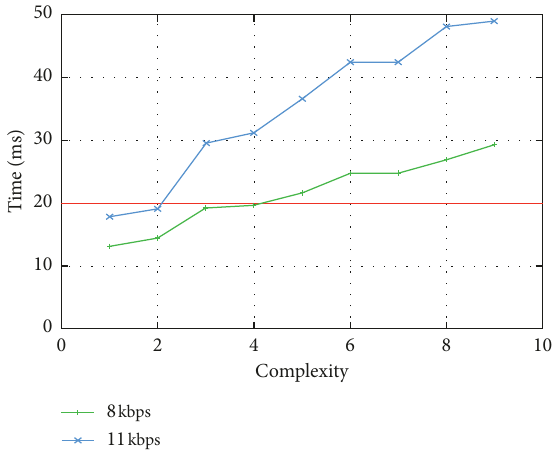
Figure 5: Execution time of the DSP